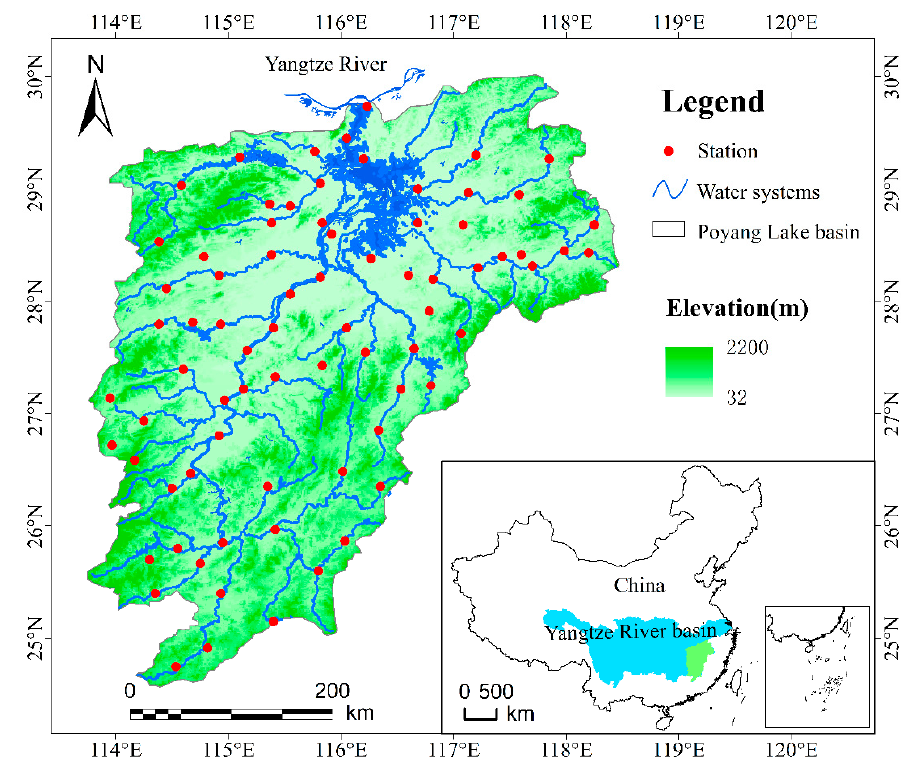
Figure 1. Distribution of meteorological stations over the Poyang Lake basin.